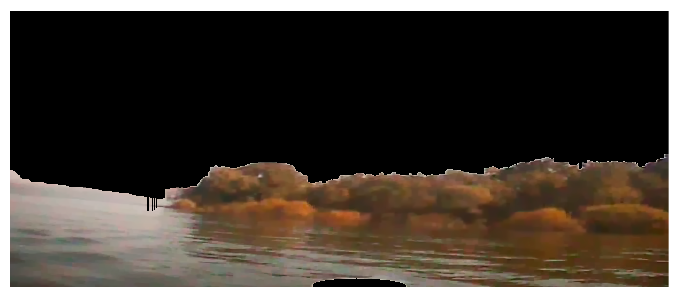
Figure 4. The result after our image preprocessing.